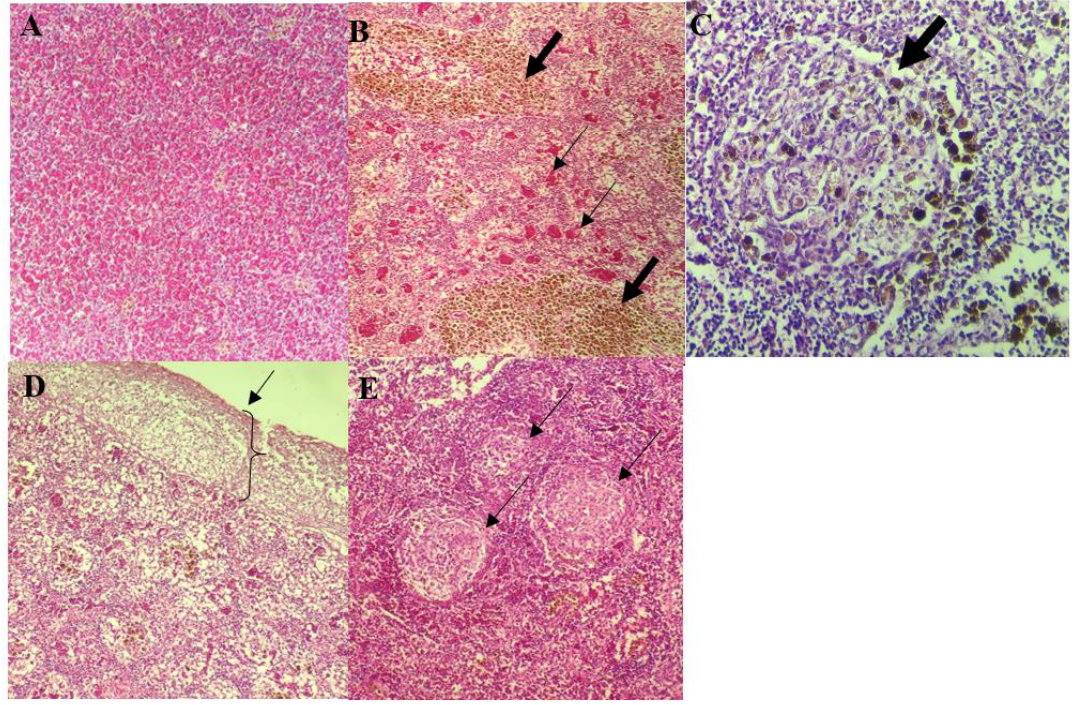
Figure 3. Histological findings of the spleen of control and infected red hybrid tilapias by Aeromonas spp. ( A ) Normal spleen of control fish showing normal splenic architecture, 200 × . ( B ) Presence of abundant MMC (thick arrow) and multiple areas of splenic vascular congestion (thin arrow), 400 × . ( C ) Severe, focal area of necrosis (arrow), with the presence of MMC, 400 × . ( D ) Severe necrosis observed mainly at the splenic surface. 200 × . ( E ) Multifocal areas of splenic white pulp hypoplasia (arrow), 200 × .